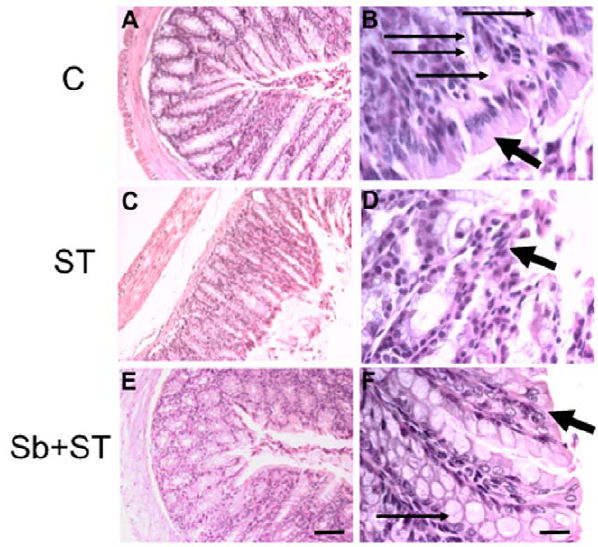
Figure 2. S. boulardii protects colon against S . Typhimurium lesions. Representative histopathological aspects of large intestine sections in control (A, B); ST (C, D), and Sb + ST (E, F) groups. Notice the integrity of surface colonocytes in B and F (large arrows) contrasting with edema (C), the loss of integrity of epithelial layer and reactive changes of the colonocytes (D, large arrows). Shortening of mucosa length (C) and decrease in goblet cells (D) were observed in the ST group, which were preserved in control (A, B) and in Sb + ST (E, F, thin arrows). H&E, Bar =20 m m (A, C, E) and 2 m m (B, D, F). C (control), ST ( S . Typhimurium), Sb ( S. boulardii